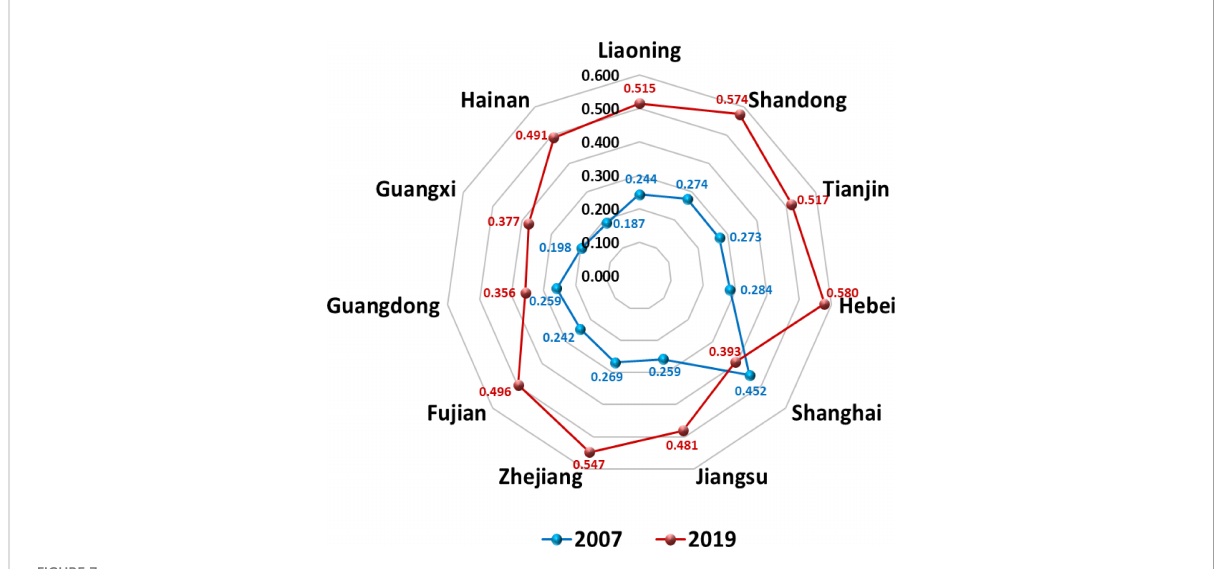
FIGURE 7 Conjugation degree of Marine Composite System in China ’ s coastal areas in 2007 and